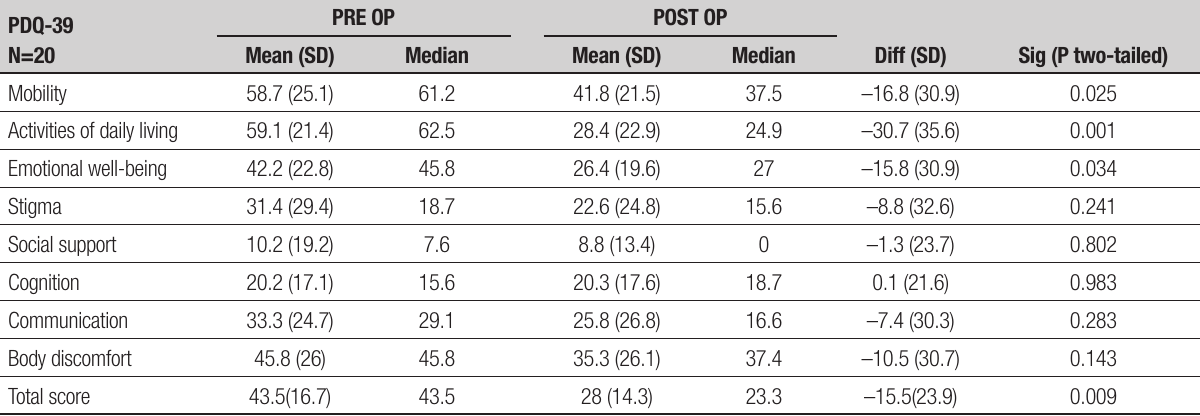
Table 3. Comparison of